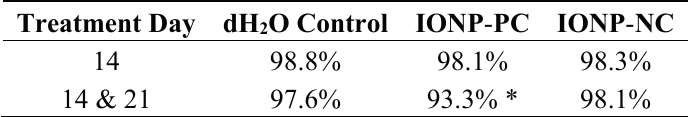
Table 2. Percentage of viable pollen in IONP treated A. thaliana using aniline blue